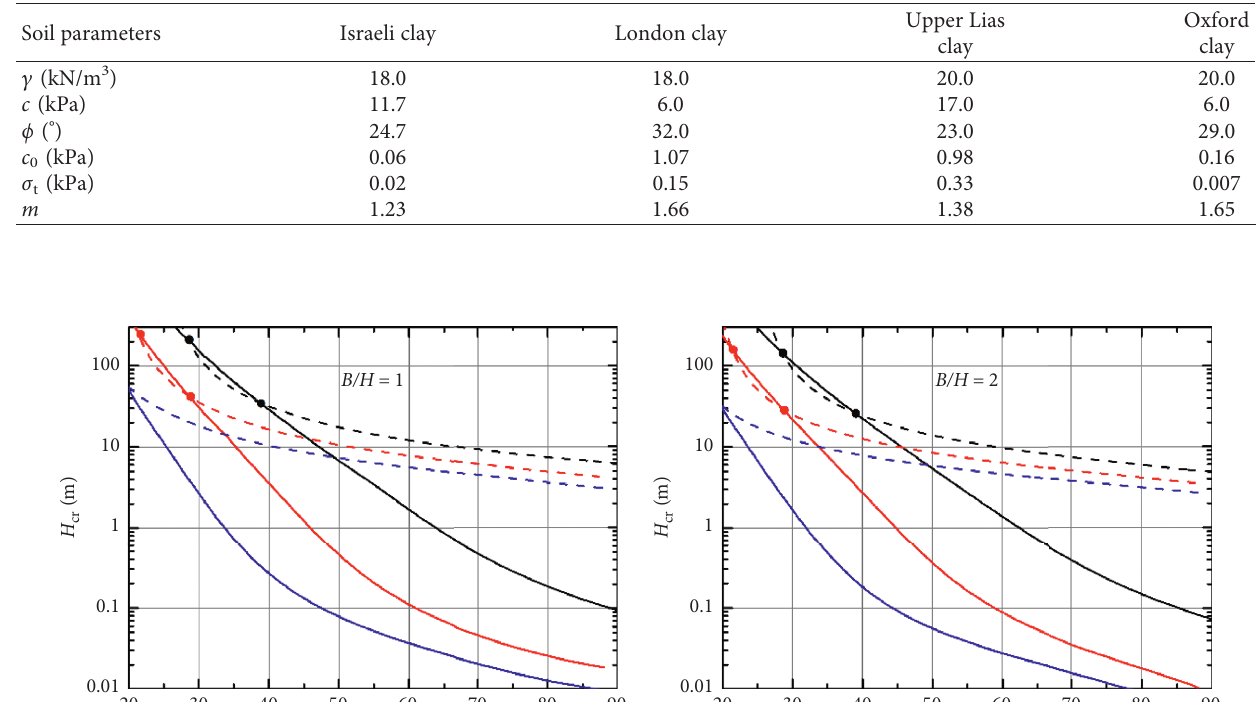
Table 1: Unit weight and strength parameters for four clays.